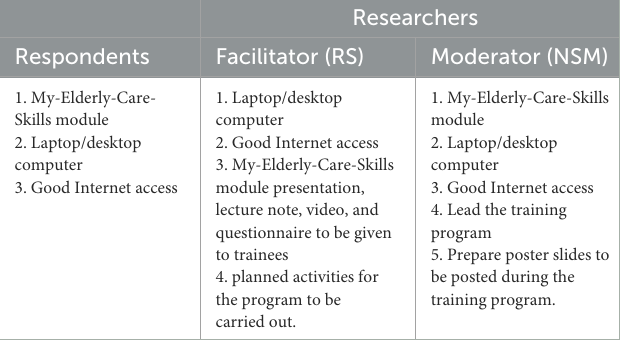
TABLE 1 List of materials used and the roles of the researchers and